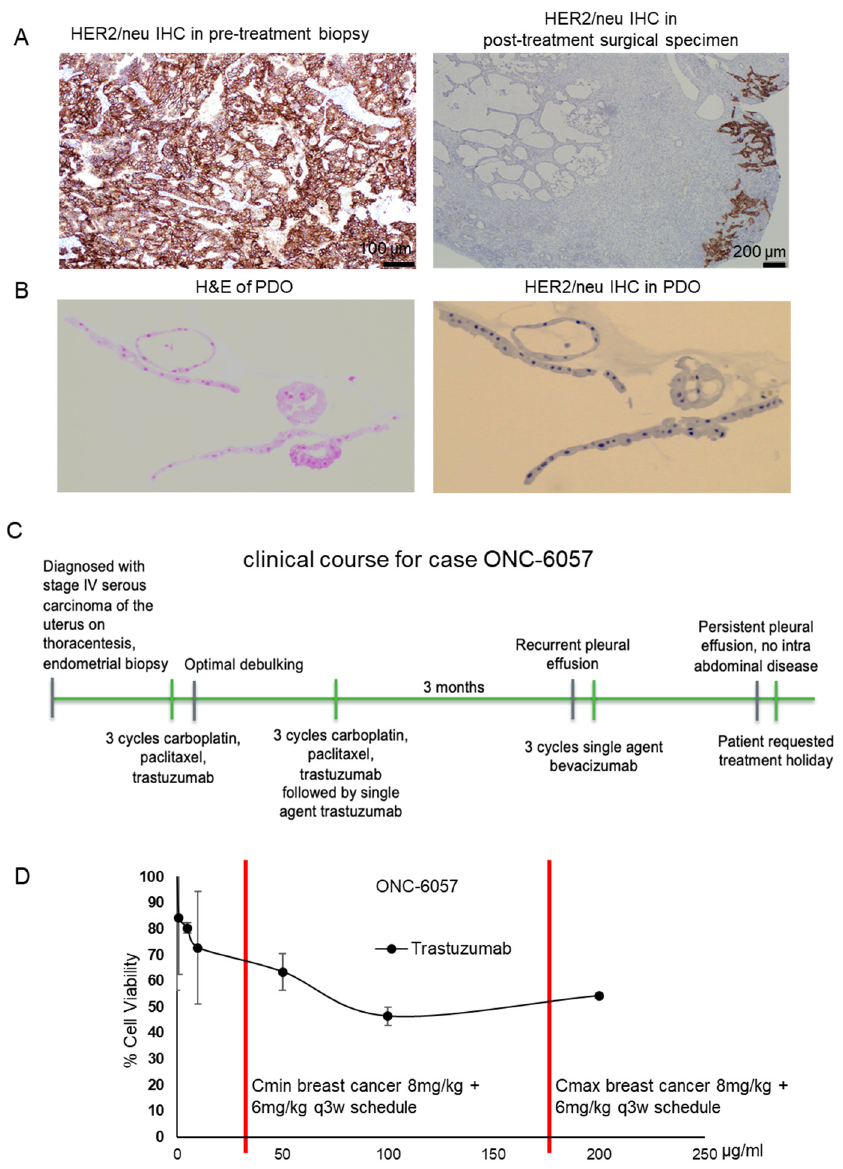
Figure 3. One advanced-stage high-grade serous endometrial carcinoma PDO model (ONC-6057) successfully predicted the patient’s clinical platinum and trastuzumab resistance. ( A ) HER2 IHC of the patient’s tumor obtained from the pretreatment biopsy and the posttreatment surgical specimen. Additional images are provided in Supplementary Figure S2. ( B ) H&E staining and HER2 IHC for the corresponding PDO model. Additional images are provided in Supplementary Figure S3. ( C ) Timeline of the patient’s clinical course. ( D ) PDO cells were treated with increasing concentrations of trastuzumab for 72 h, followed by assessment of cell viability. The data were calculated as the cell viability (%) relative to the untreated control which was set at 100%. The graph is annotated with the Cmin and Cmax values for trastuzumab used clinically in breast cancer. Note that an IC50 was not achieved with trastuzumab, even at concentrations greater than the Cmax.